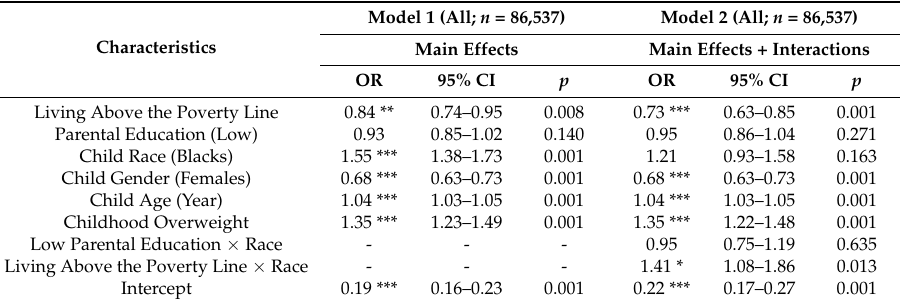
Table 3. Summary of logistic regression models in the pooled sample.